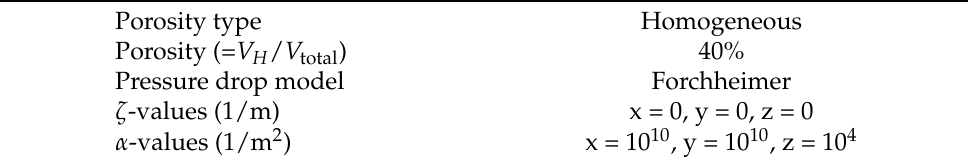
Table 1. Input parameters for the porosity